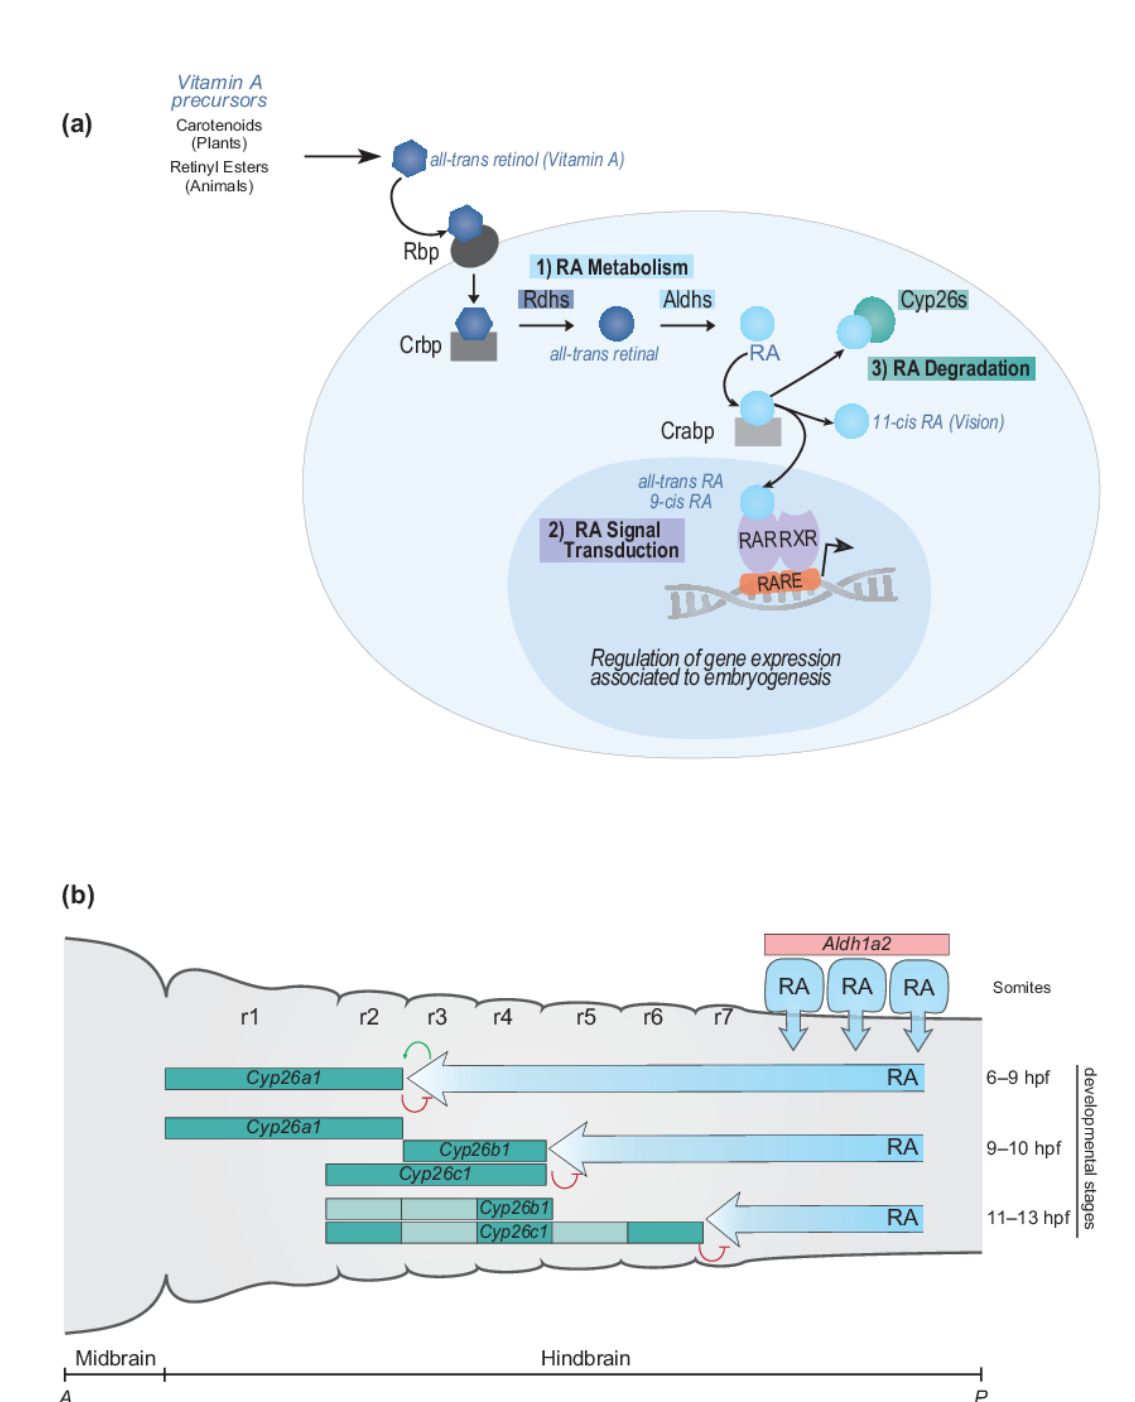
Figure 2. RA signaling pathway and RA morphogen gradient during hindbrain development. ( a ) Simplified schematic representation of major steps of the RA signaling pathway and main components of the RA machinery. The RA signaling pathway converts Vitamin A to RA following three important steps: (1) RA metabolism, (2) RA signal transduction and (3) RA degradation. The RA machinery includes main actors of the signaling pathway: RA synthesizing and degrading enzymes (Rdhs; Aldhs; Cyp26s), transport proteins (Rbp; Crbp; Crabp), nuclear hormone receptors (RAR-RXRs), and Retinoic Acid Response Elements (RAREs). ( b ) Schematic depiction of the dynamic regulation of endogenous levels of RA during hindbrain development. The RA morphogen gradient is set up by synthesizing and degrading enzymes of the RA machinery in the context of the vertebrate hindbrain. Aldh1a2 is expressed in the somites where Aldh1a2 localizes and synthesizes RA. The spatially and temporally dynamic segmental expression of Cyp26a1 , Cyp26b1 , and Cyp26c1 induces shifting domains of Cyp26 degrading activity, which act as anterior sinks of RA activity, therefore generating a precise and gradual set up of the RA morphogen gradient. The developmental time points correspond to zebrafish development. A, anterior; P, posterior; r,